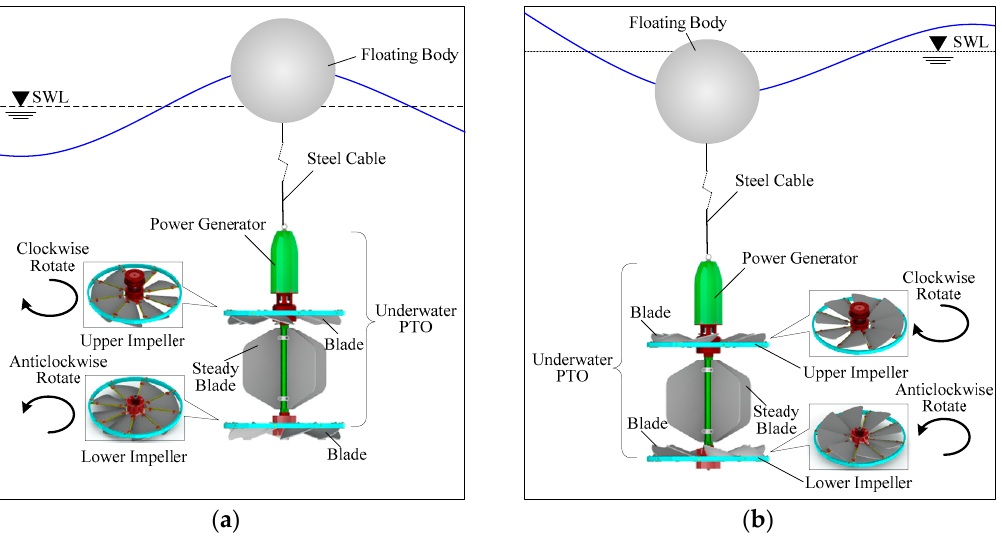
Figure 2. The system configuration and working principle of the novel heaving point absorber. ( a ) Rising state; and, ( b ) Sinking state.